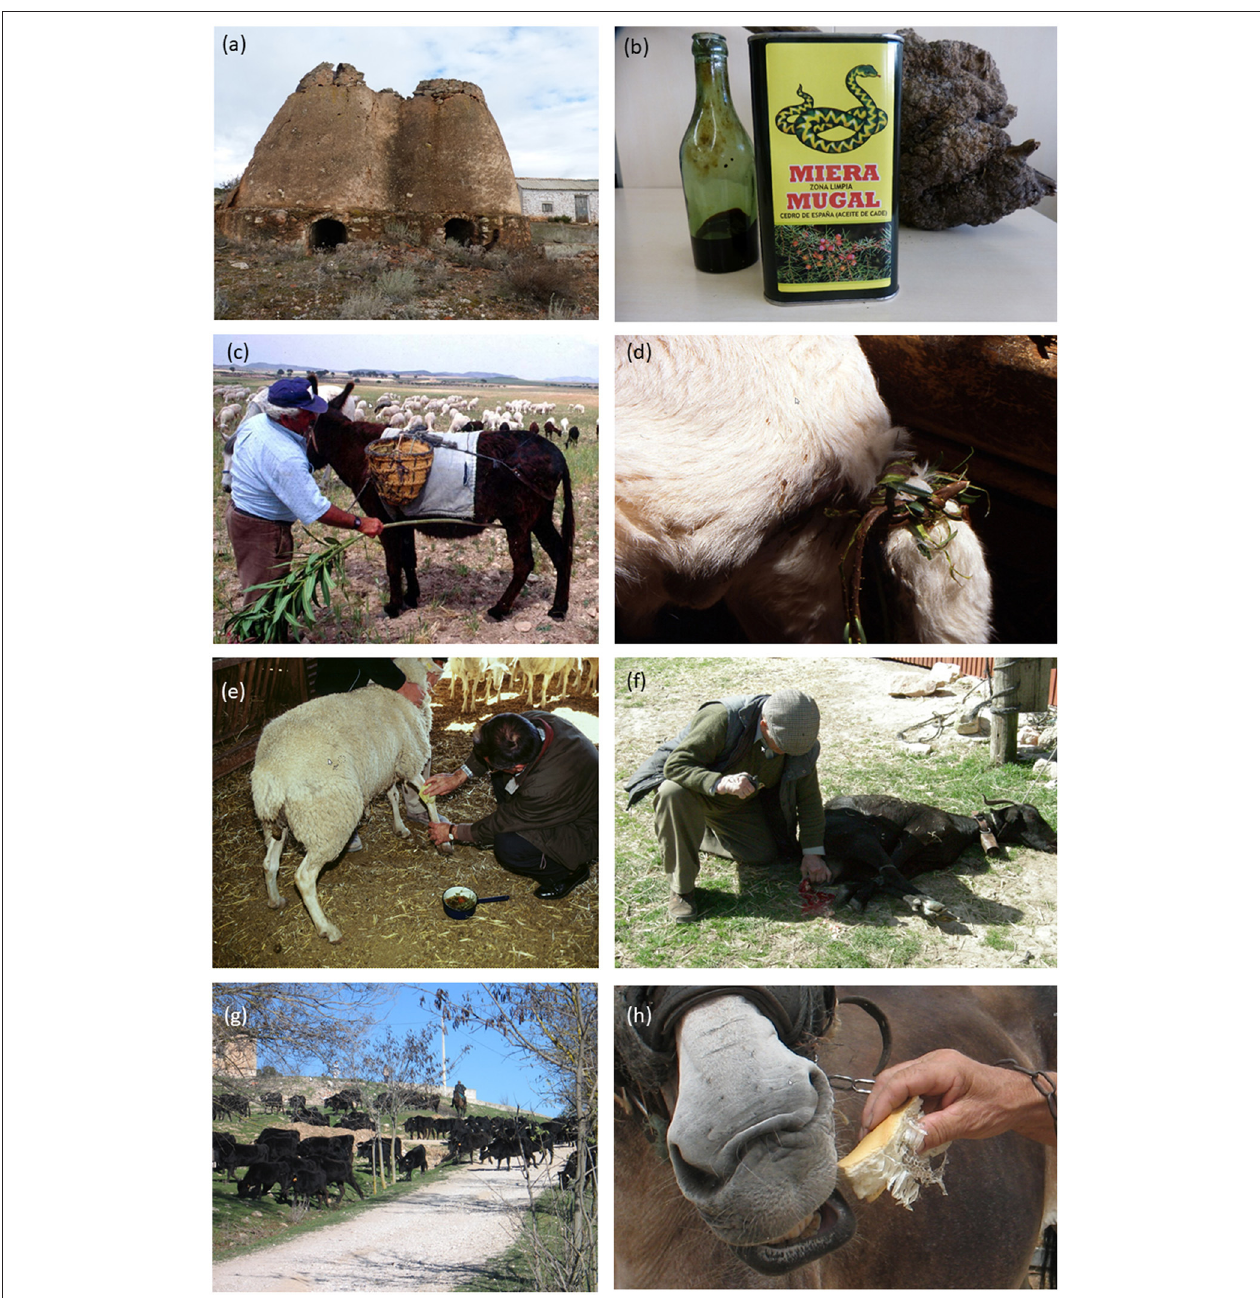
FIGURE 4 | Selected practices and ethnoveterinary ingredients. (a) “Miereradel Charco” proto-industrial facility. (b) Commercial “miera” or juniper distilled resin. (c) Use of an oleander branch to massage a donkey’s belly. (d) Braid of torvisco branch bark tied to the tail of a lamb to control diarrhea. (e) Curing a sheep’s foot with a decoction of medicinal plants. (f) Treatment of mastitis in the udder of a goat. (g) Transhumant cattle crossing Olmeda del Rey (Cuenca). (h) Feeding a mule with bread and snakeskin sandwich to treat a cold, Abengibre (Albacete). Photos: J. Fajardo and A. Verde. Malvaceae the decoction of the aerial part to reduce inflammation of udders after calving in cattle; of the flower for colds Malva sylvestris L. (24 records, 1.7%): leaves and flowers of in fumigations; of blooming branches to catch flies, soaked this species in this area are directly, or after being crushed or in buttermilk and hung in stables; and of dried flowers decoction, applied to treat bruises, inflammation and disorders heated in olive oil for sore or inflamed body parts in goats of the hoof, and are administered for bloat in ruminants and cows. and